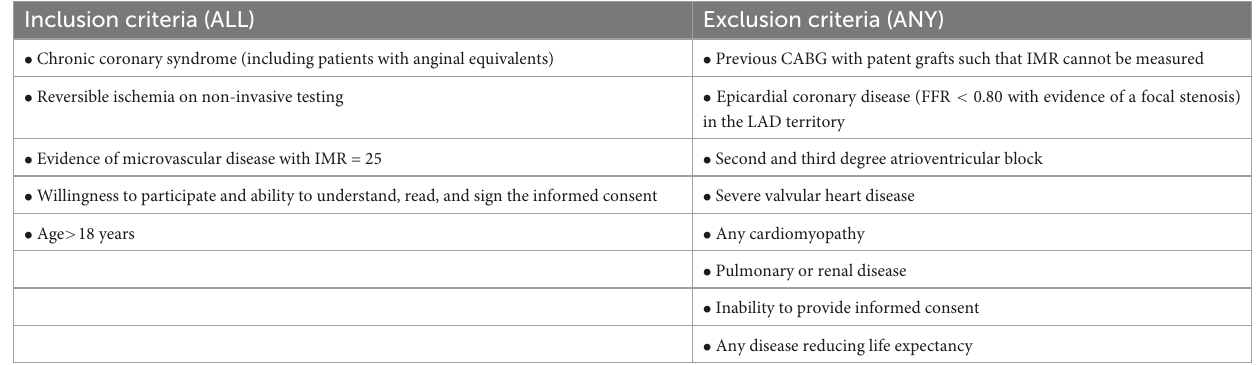
TABLE 1 In- and exclusion